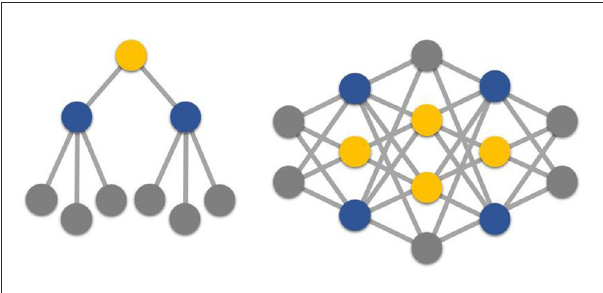
FIGURE1 Two model arrangements of scientific groups: (Left) the conventional pyramidal system, with top-tier researchers as sole leaders; (Right) the network system, with network researchers integrated within the same research